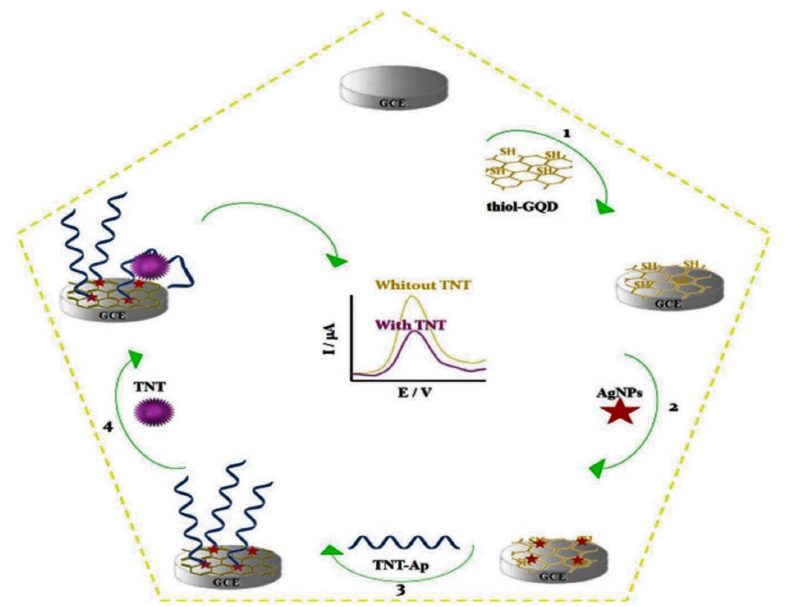
Figure 11. Scheme for the synthesis of an electrochemical aptasensor for quantification of TNT. Taken from [93], copyright 2019,